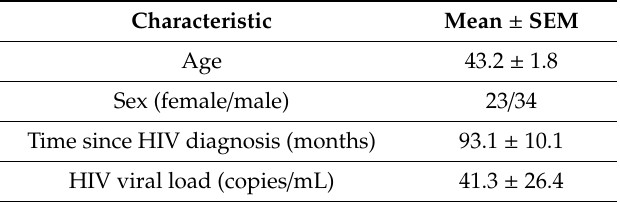
Table 1. Main clinical characteristics of the 57 HIV + subjects included in the